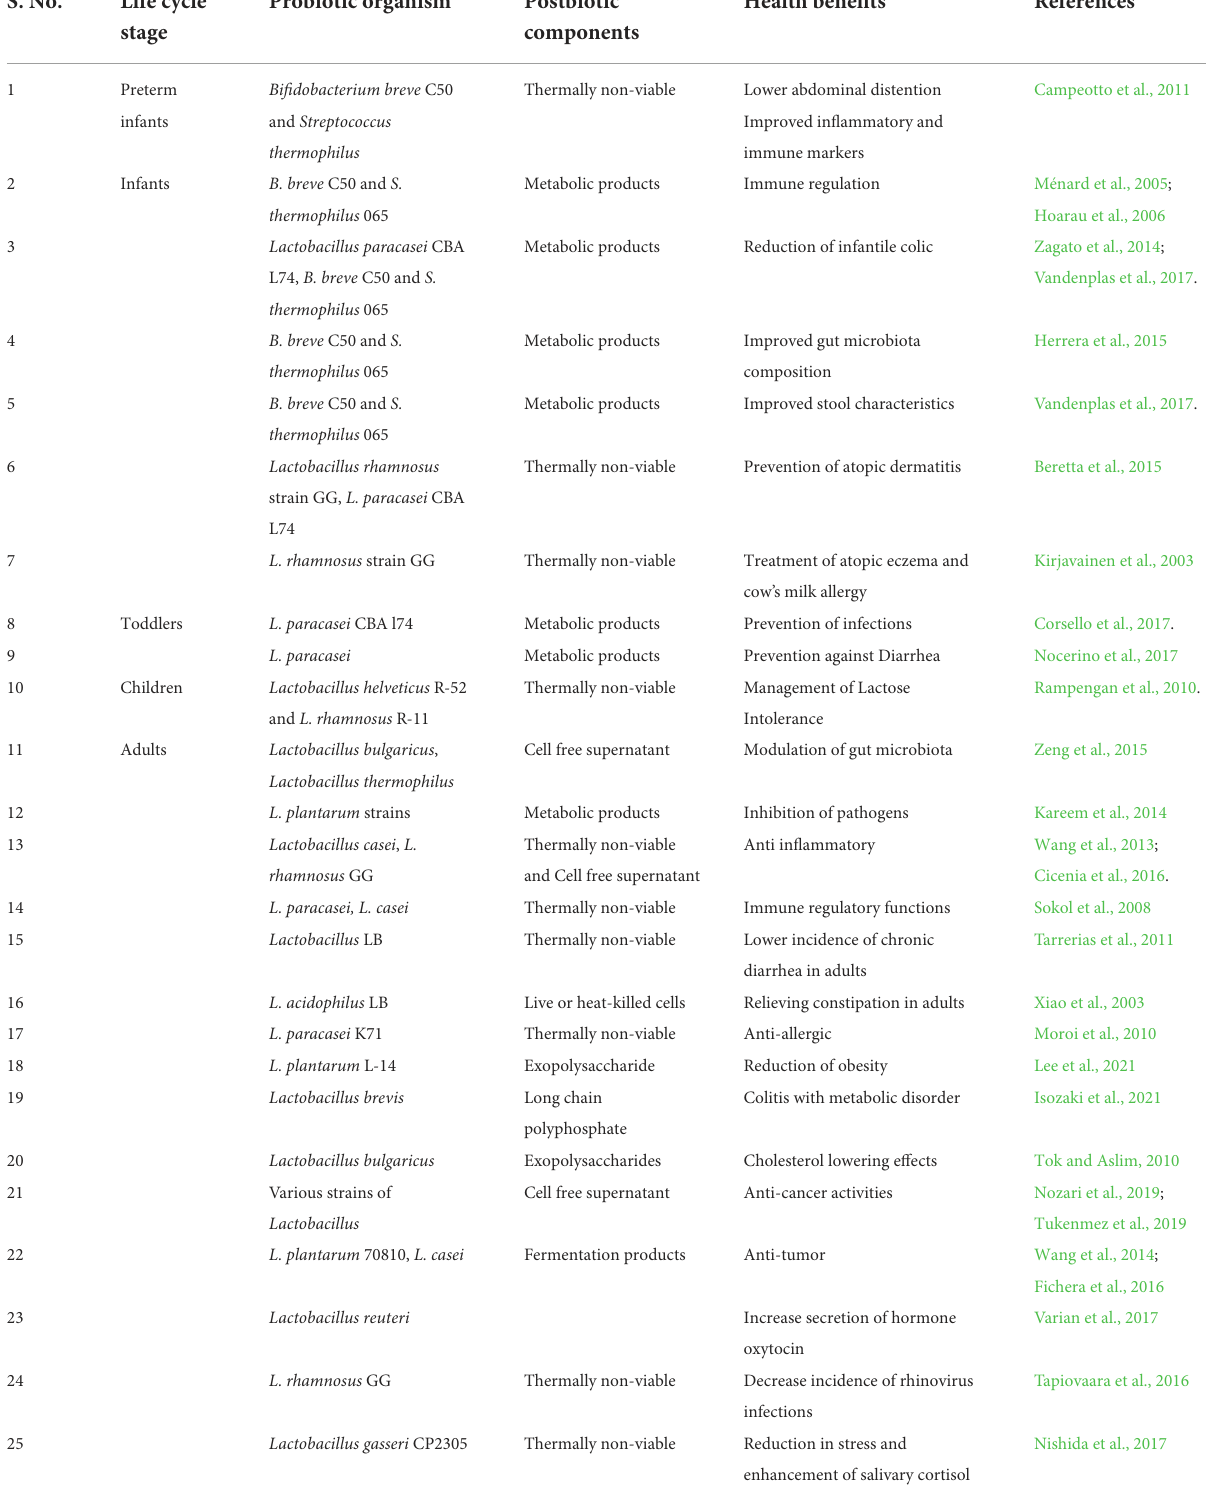
TABLE 1 Health benefits of postbiotics through the life-cycle. S.